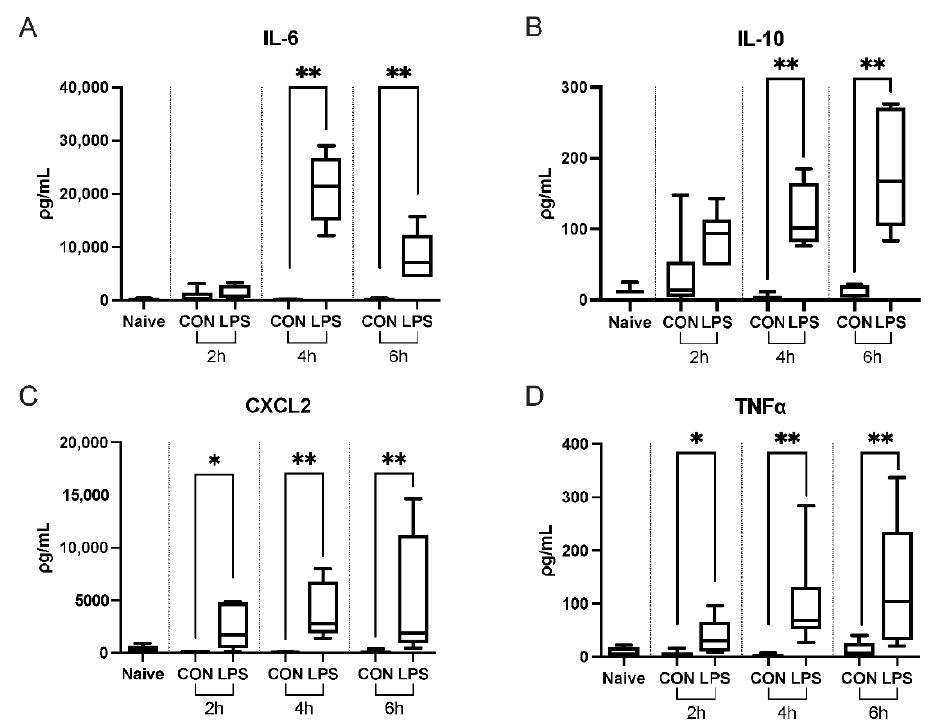
Figure 2. Systemic upregulation of cytokines following ALI. Plasma levels of ( A ) IL-6, ( B ) IL-10, ( C ) CXCL2, and ( D ) TNF α were elevated at 4 and 6 h post-induction. Whiskers show minimum and maximum values, boxes represent 25–75% data ranges, and horizontal lines within boxes represent medians. Statistically significant differences were determined via Mann–Whitney tests between LPS and control groups at each timepoint and are depicted as * p ≤ 0.05, ** p ≤ 0.01.